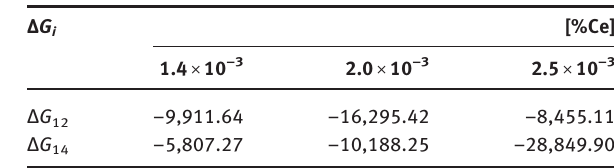
Table 6: Activity of each element for experimental steels at 1,873K.